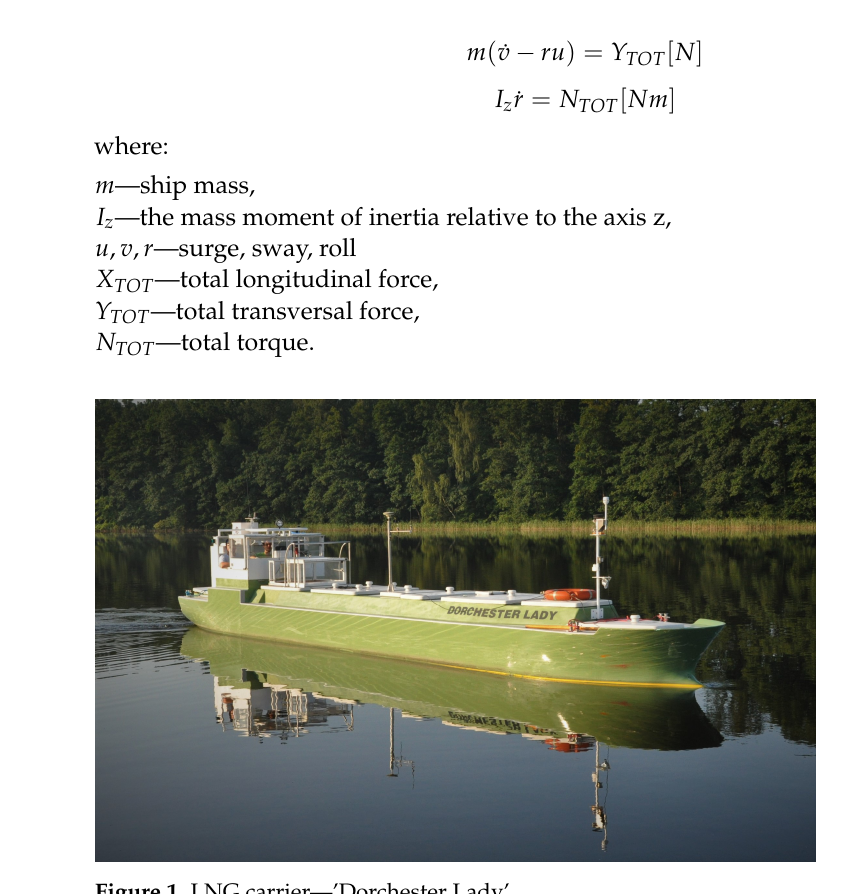
Figure 1. LNG carrier—’Dorchester